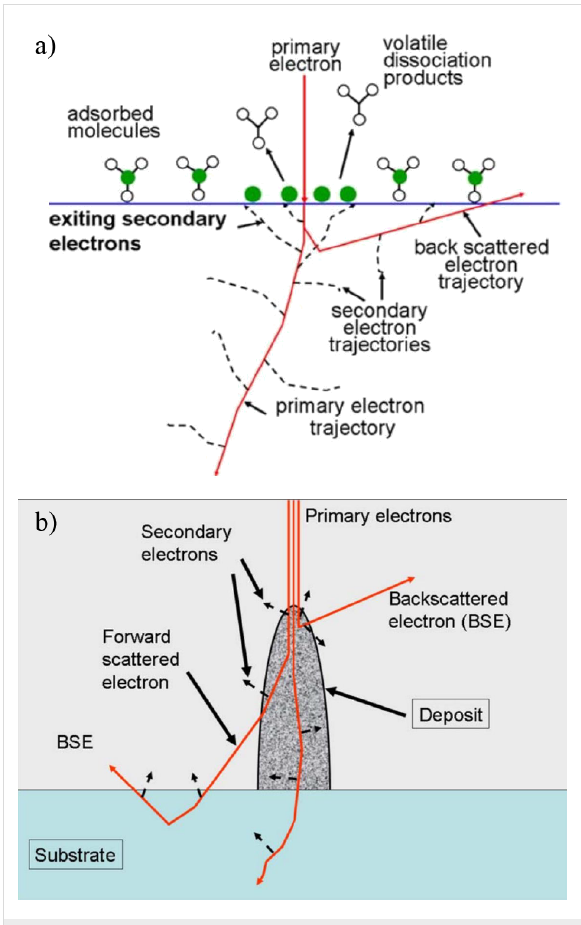
Figure 2: Schematic representation of elastic and inelastic scattering of high-energy primary electrons impinging on a solid substrate and of the generation of SEs through inelastic ionization processes (repro- duced with permission from [2], Copyright (2008) American Vacuum Society). (a) Primary electrons impinging on the surface and pene- trating the substrate will in part be backscattered and will exit the surface within an area defined by the scattering angle and the electron energy. These electrons lose energy as a result of inelastic, ionizing processes, which in turn, give rise to a large amount of secondary electrons (SEs) produced within the substrate, and more importantly, these SEs are also produced at or close to the surface of the sub- strate. (b) The same process depicted for a three-dimensional struc- ture growing under the exposure of precursor molecules to the high- energy PE beam. In this case, forward scattered electrons can also